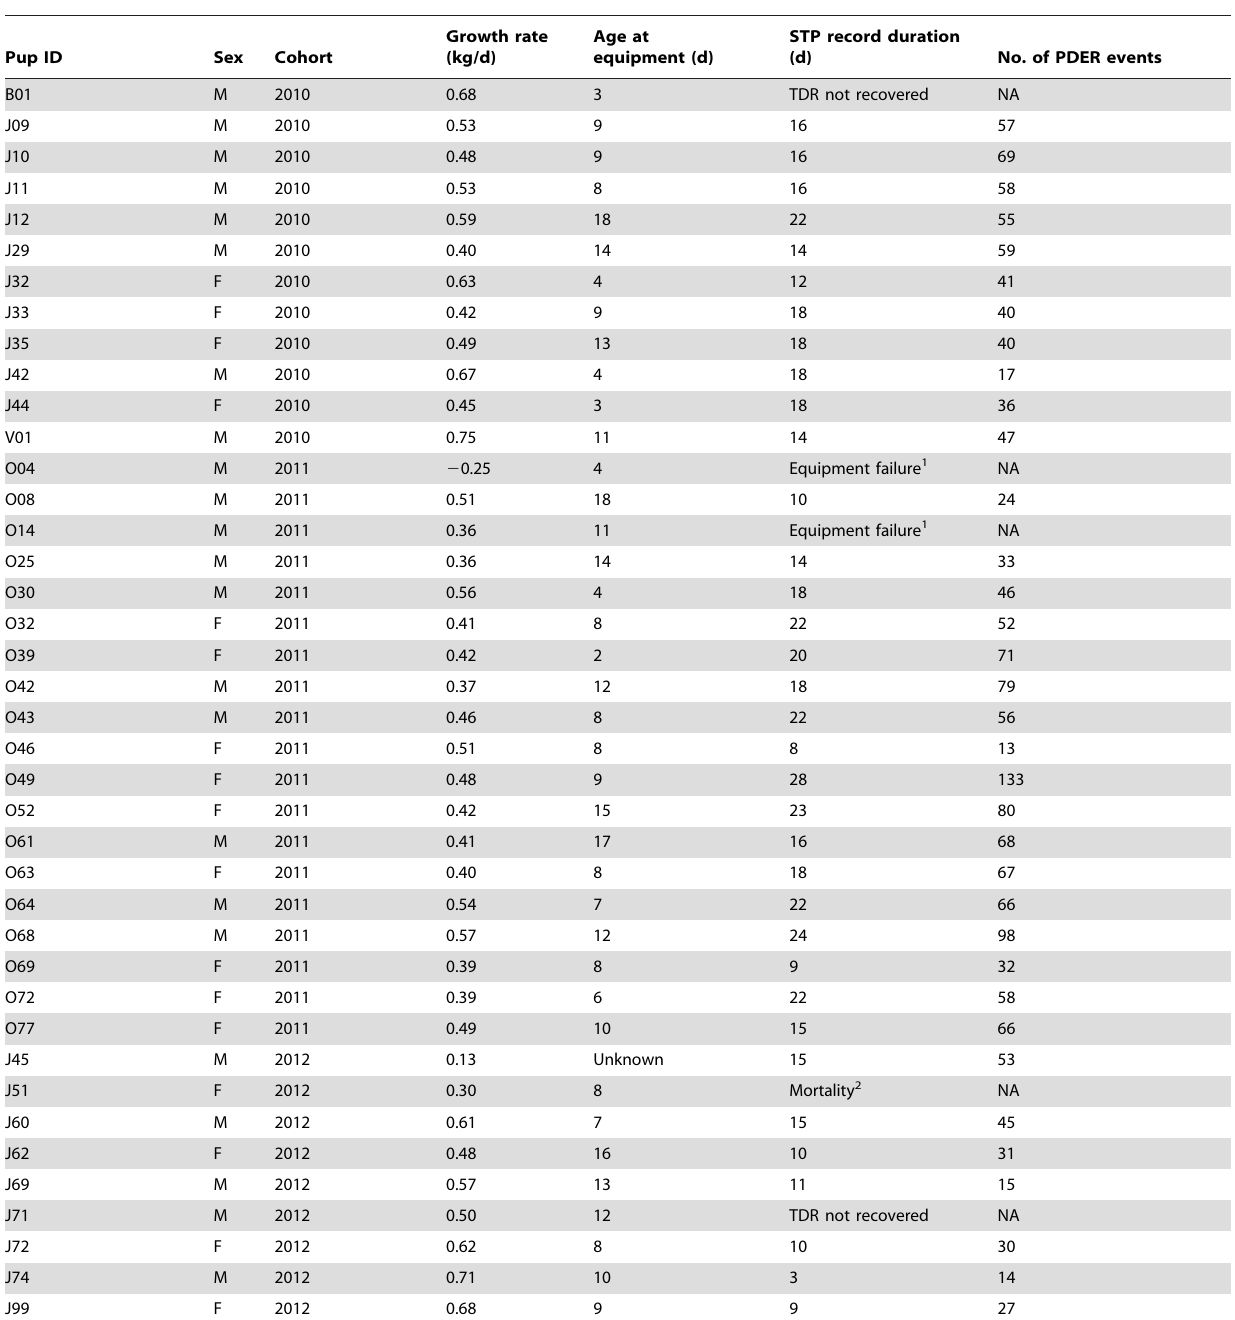
Table 1. Characteristics of harbour seal pups ( n = 40) equipped with STPs during the 2010–2012 nursing periods at Bic Island, Quebec,